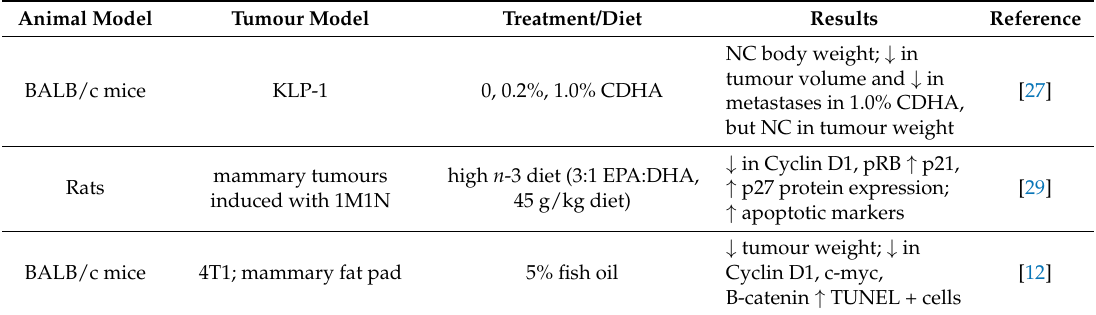
Table 2. Overview of in vivo studies investigating cell cycle in cancer cells treated with docosahexaenoic